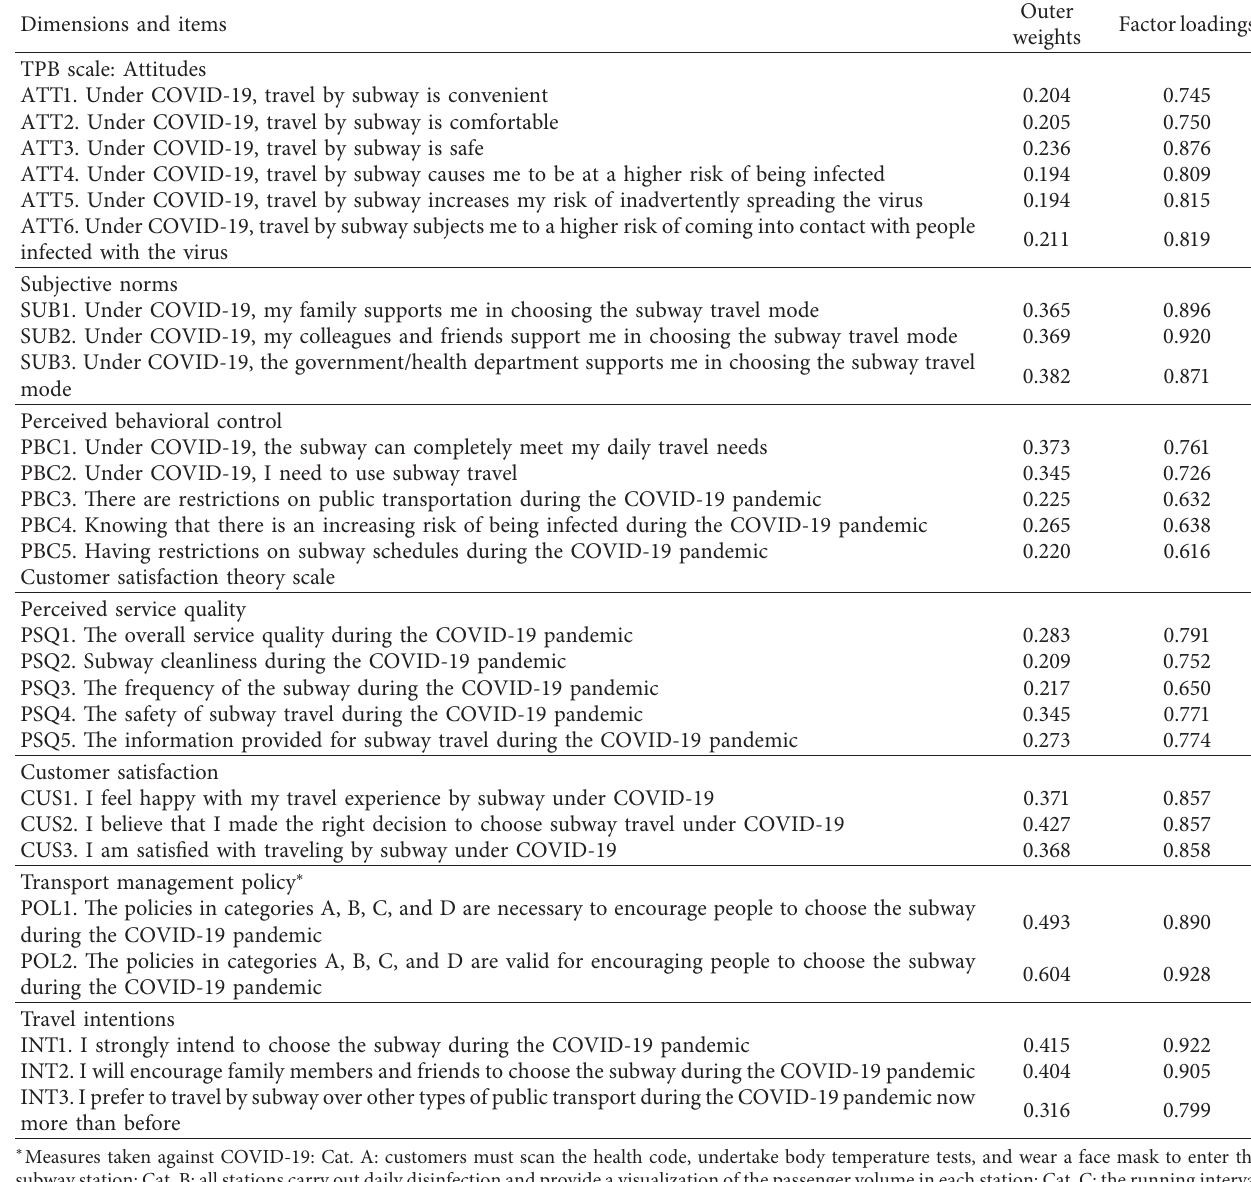
Table 2: Outer weights and loading coefficients of the model.